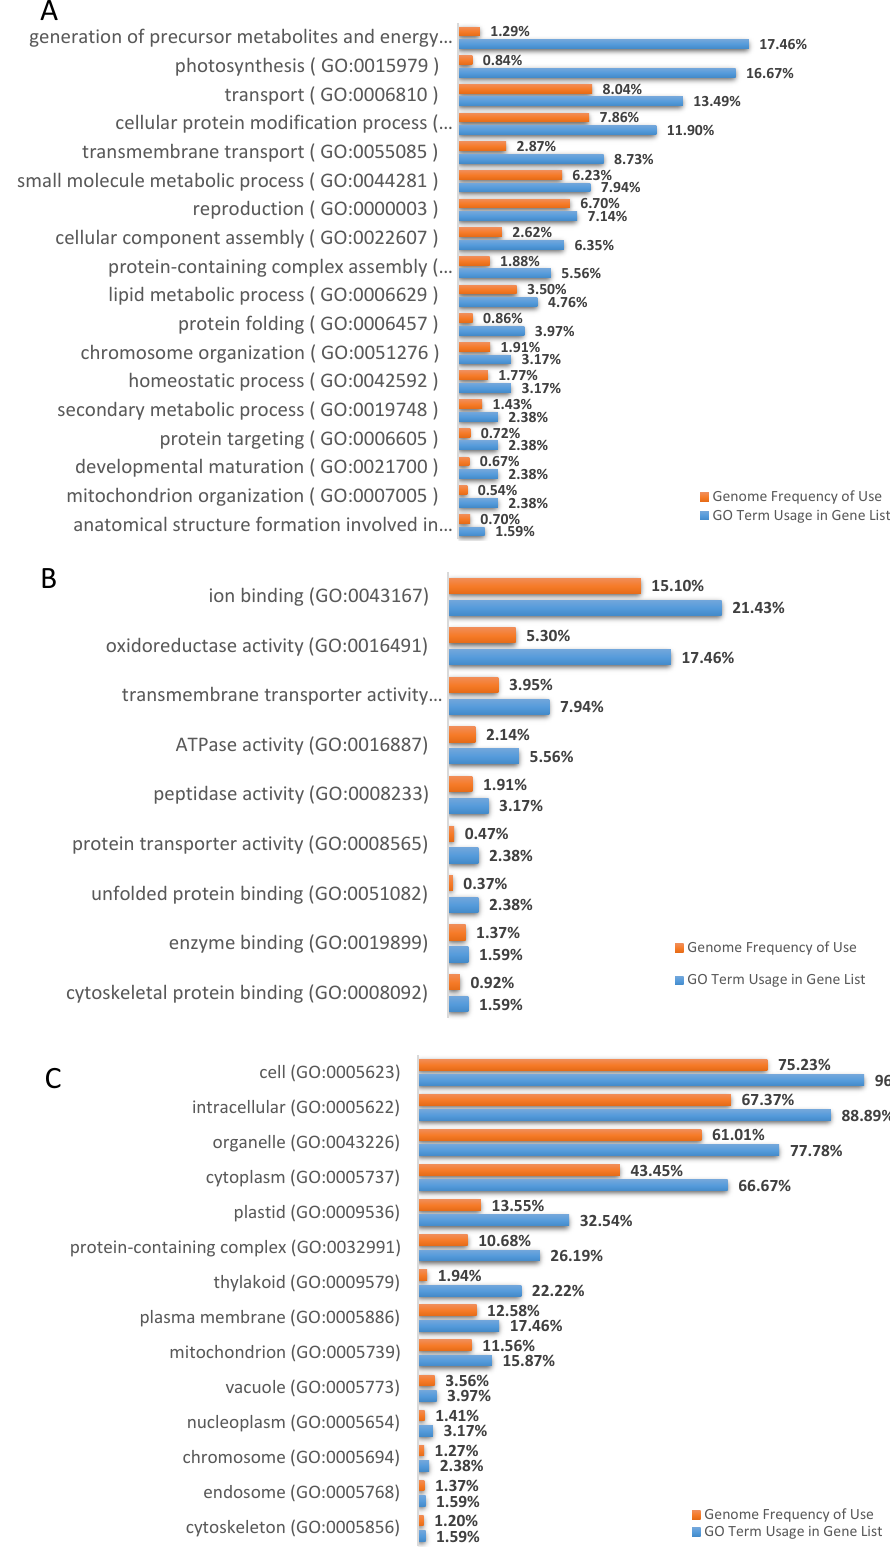
Figure 4. Gene ontology (GO) categorization of genic DML—( A ) biological processes; ( B ) molecular functions; ( C ) cellular components. The blue bars indicate input, represented by all true-to-type and o ff -type loci, while the orange bars indicate background genome